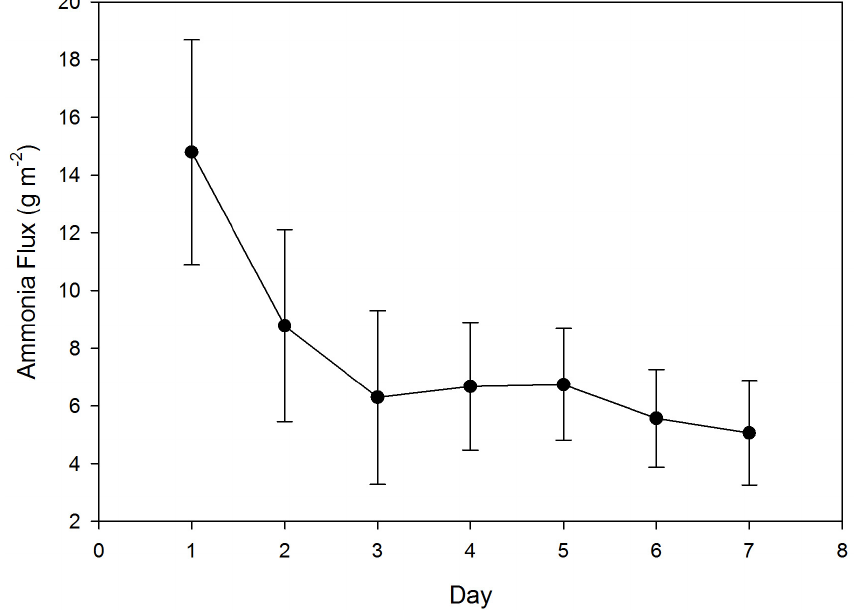
Figure 3. Example of typical daily (24 h) ammonia flux pattern from an intact feedlot pen sample collected under drier conditions. Samples in this study were taken during the summer from urine patches at a commercial feedlot in northern Colorado and processed and analyzed in the same way as samples in this study. Error bars represent ±1 standard deviation as calculated from six